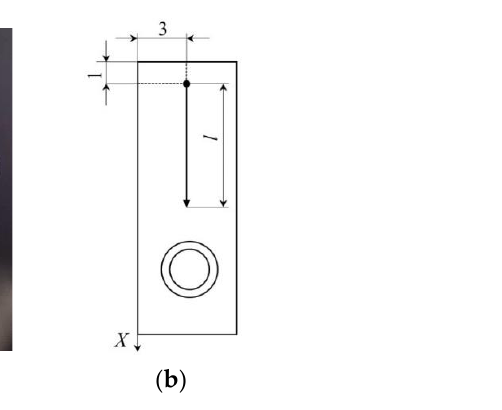
Figure 2. Image of the sample ( a ) in the erosion test rig chamber and the scheme for measuring the surface profile ( b ).